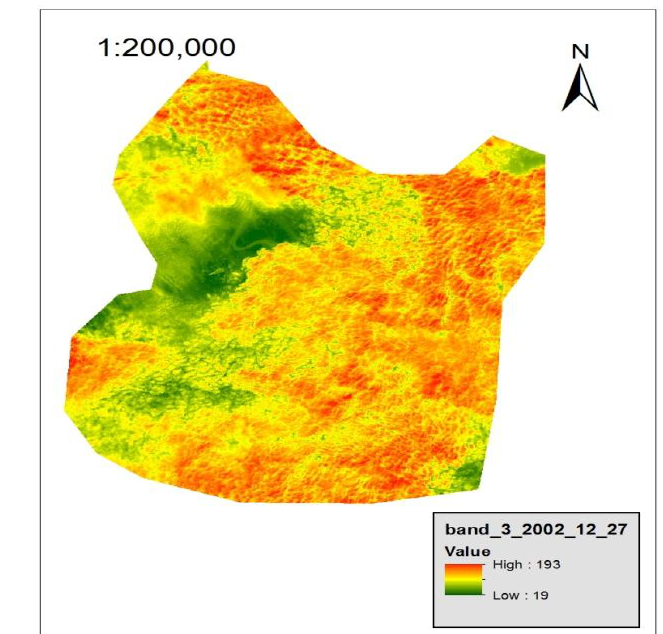
Fig.5: Show image extraction of band (3) for study area in date (27/12/2002).